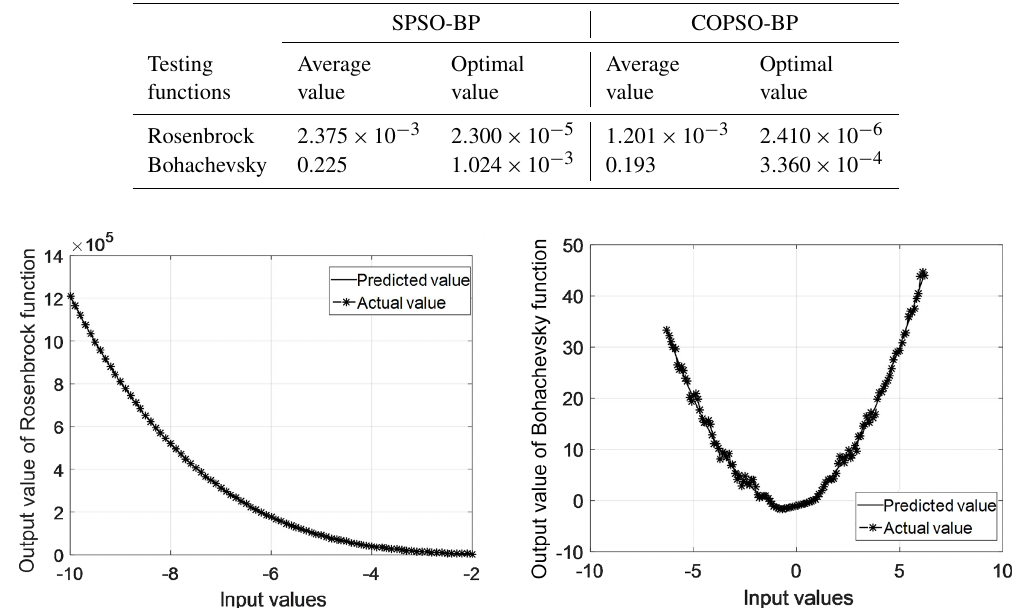
Figure 4. Fitting curves of the COPSO-BP